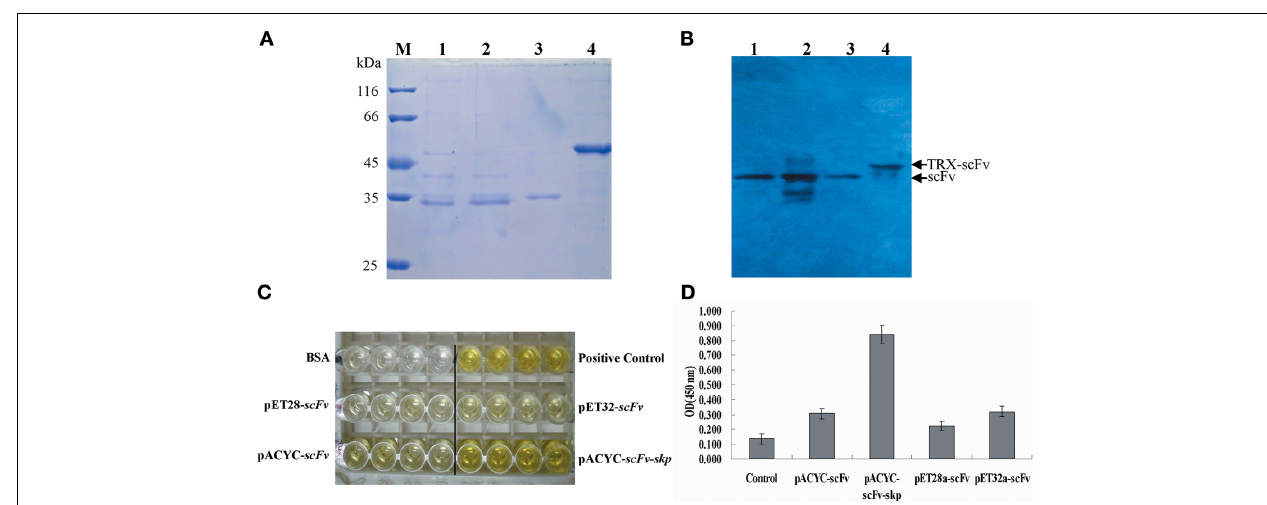
FIGURE 4 | Protein purification and identification. (A) Protein purification. The purified protein was determined by SDS-PAGE. M: Molecular weight of marker proteins; Lane 1–4: the purified proteins for pACYC-Duet- scFv , pACYC-Duet- scFv - skp , pET28a- scFv , and pET32a- scFv , respectively. (B) Western blotting results. Lane 1–4: the detected bands for pACYC-Duet- scFv , pACYC-Duet- scFv - skp , pET28a- scFv , and pET32a- scFv ,